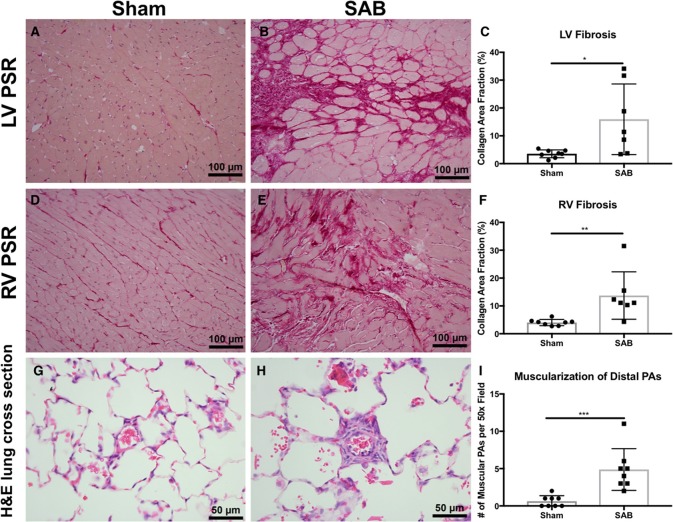
Histology and confocal microscopy images of sham vs. supra-coronary aortic banding (SAB) rats. Picrosirius red (PSR) staining of left ventricle (LV), and right ventricle (RV) of (A,D) sham vs. (B,E) SAB rats showing (C,F) increased myocardial fibrosis in SAB rat. Hematoxylin and eosin (H,E) stain of lung cross section of (G) sham vs. (H) SAB rats showing (I) increased number of muscular pulmonary arteries (PAs) per 50x field. Each dot represents tissue from a unique rat.